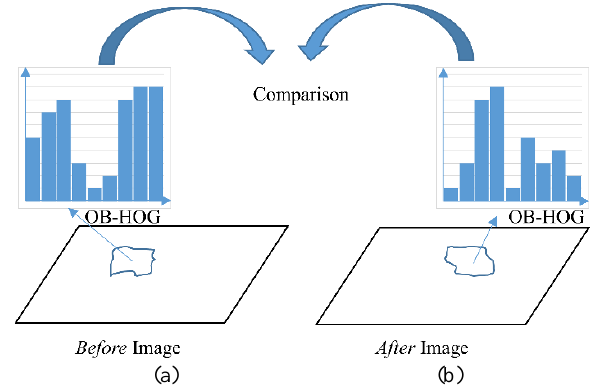
Figure 6: AUC of the OB-HOG with the ROC curve of the (a) spectral (b) textural change detection